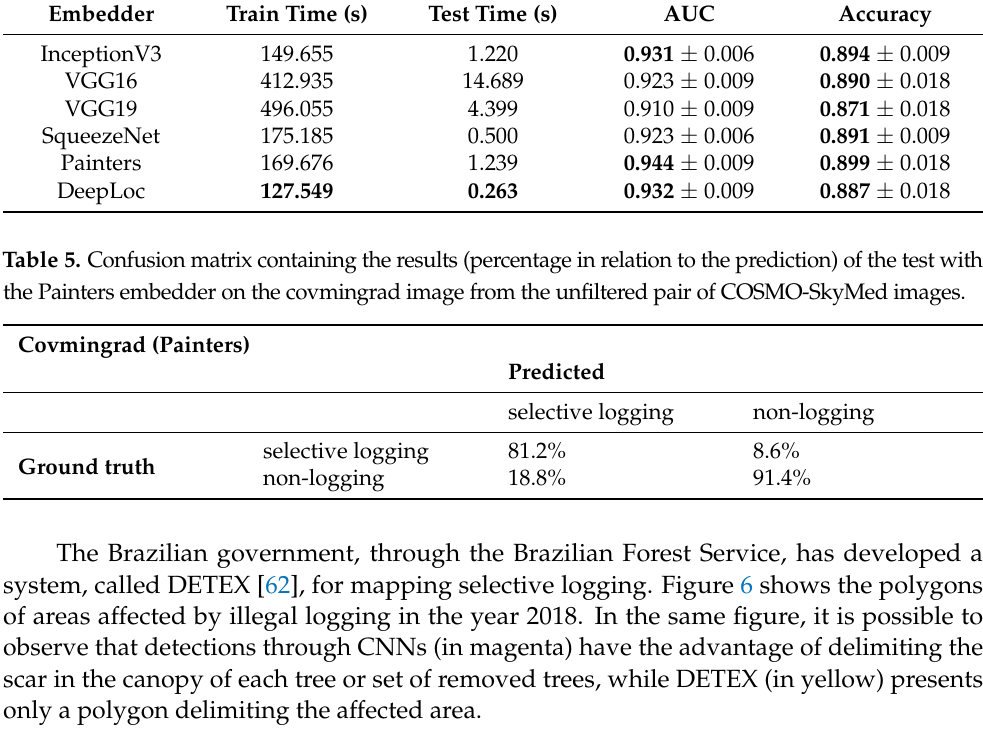
Table 4. Results of classification tests by pre-trained CNNs on the covmingrad image from the unfiltered pair of COSMO-SKYMED images. Numbers in bold represent the best values obtained.